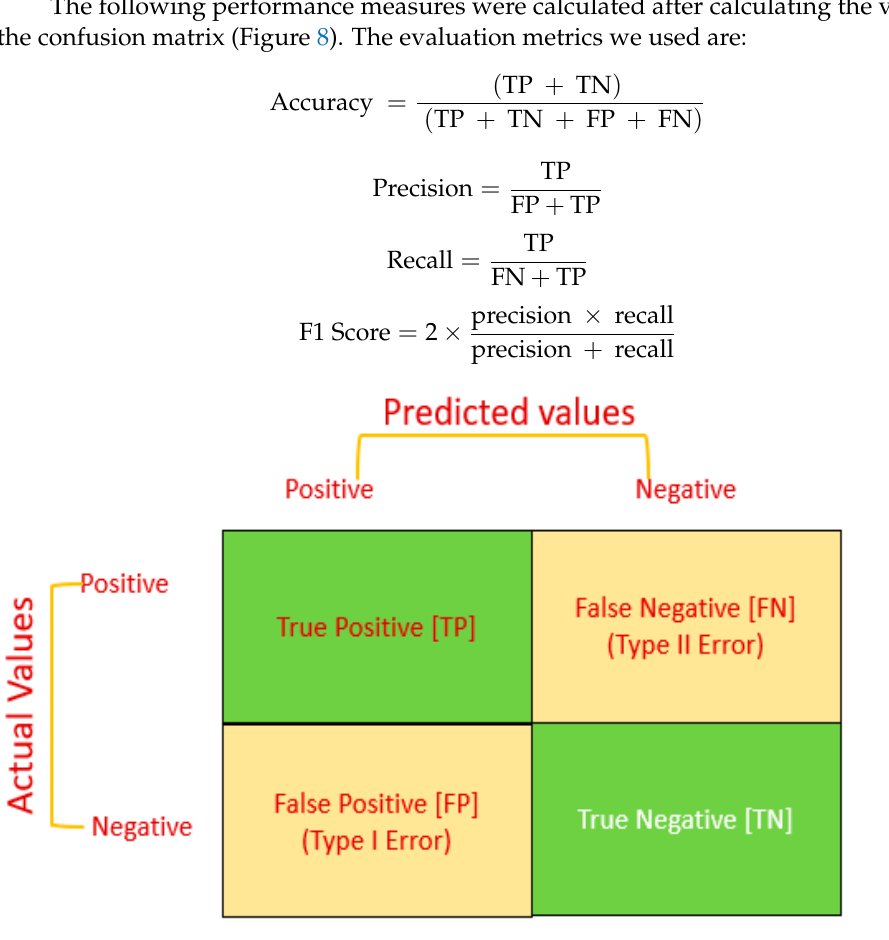
Figure 8. Confusion matrix.